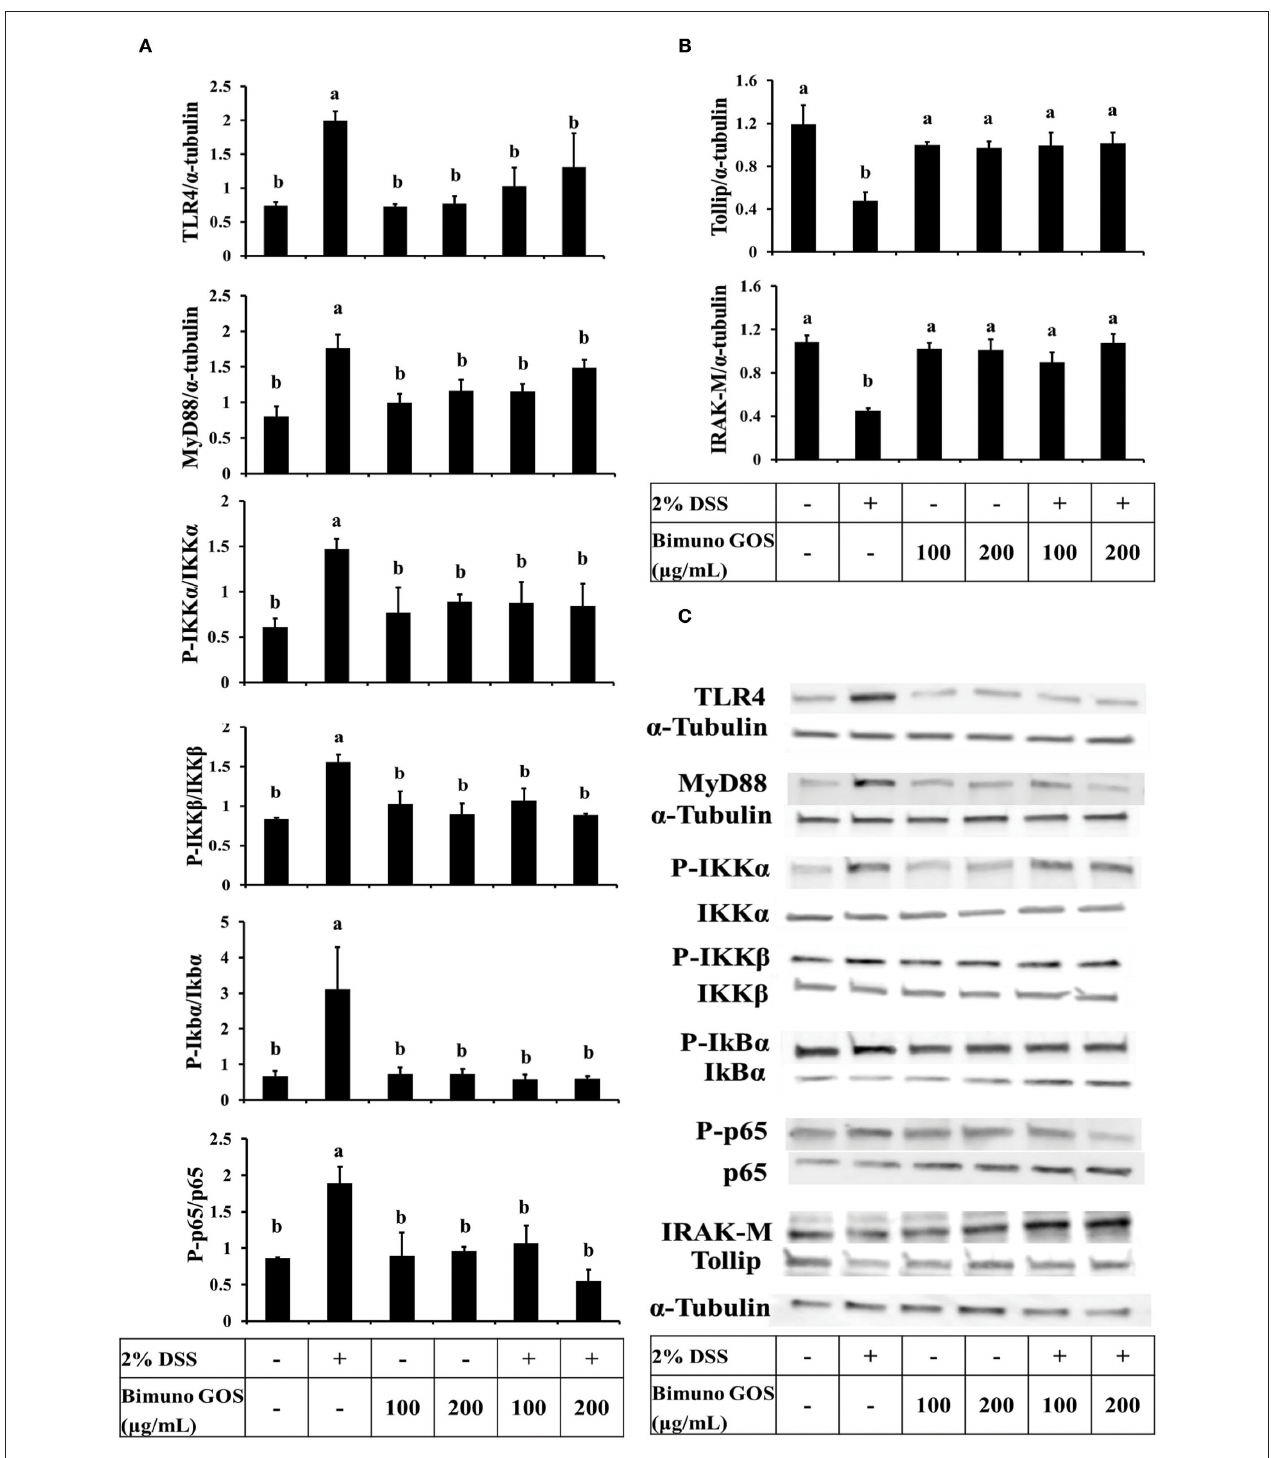
FIGURE 6 | Inhibition of DSS induced-NF-kB signaling pathway by Bimuno GOS in Caco-2 cells. Cells were untreated, or treated with 2% DSS alone for 6h, or treated with 2% DSS for 2h and then with Bimuno GOS (100 or 200 µ g/ml) for a further 4h, or treated with 100 or 200 µ g/ml Bimuno GOS alone for 4h. Protein expression was analyzed by Western blot. The relative expression levels of TLR4, MyD88, Tollip, and IRAK-M were normalized to α -tubulin, whereas the phosphorylated IKK- α , IKK- β , IkB- α , and p65 were normalized to their corresponding unphosphorylated forms. (A) TLR4, MyD88, P-IKK- α , P-IKK- β , P-IkB- α , P-p65 (densitometric values). (B) Tollip and IRAK-M (densitometric values). (C) Representative Western blot of the analyzed proteins. Values represent means ± SD of three independent experiments, carried out in triplicate. Means without a common letter significantly differ, P < 0.05.